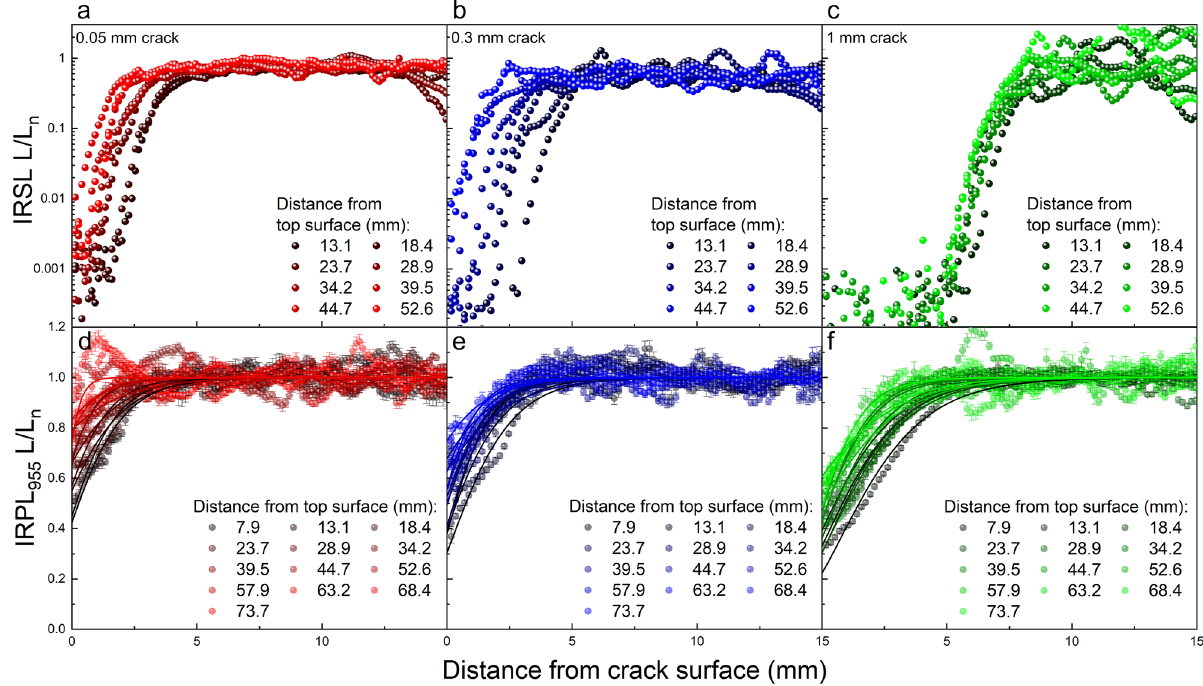
Figure 6. Normalized IRSL- and IRPL 955 -depth profiles acquired from 5 mm L-X sections at various distances from 8 to 80 mm from the top surface for the ( a ) 0.05, ( b ) 0.3 and ( c ) 1 mm crack widths. Solid curves represent the best fits of the data to Eq.